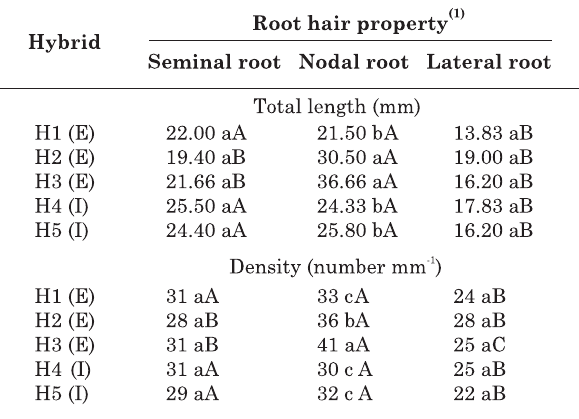
Table 3. Total length and hair density of seminal, nodal and lateral roots of maize hybrids contrasting in P-use efficiency (mean of P